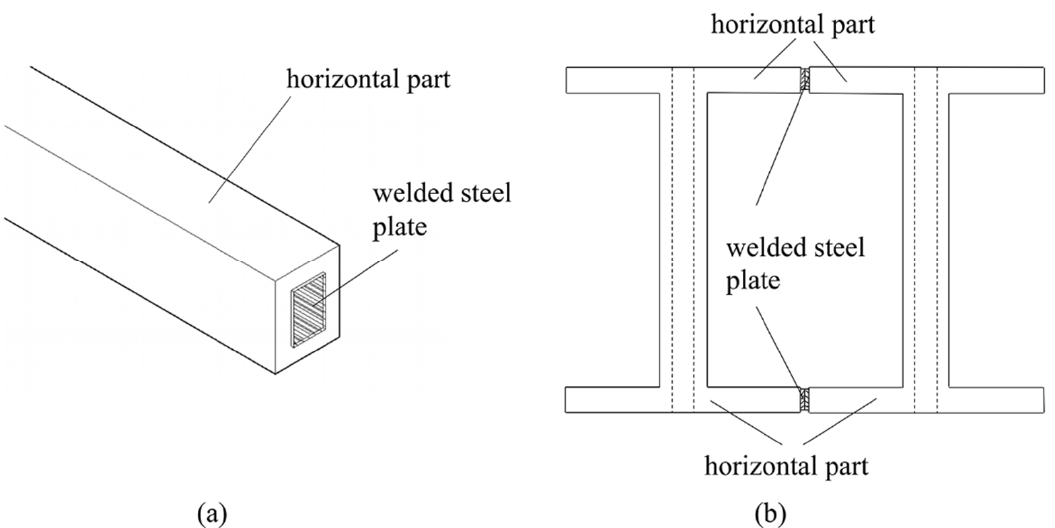
Figure 3. Horizontal connection diagrams of prefabricated cantilever components: ( a ) schematic of steel plate connector and ( b ) schematic of welding connection.